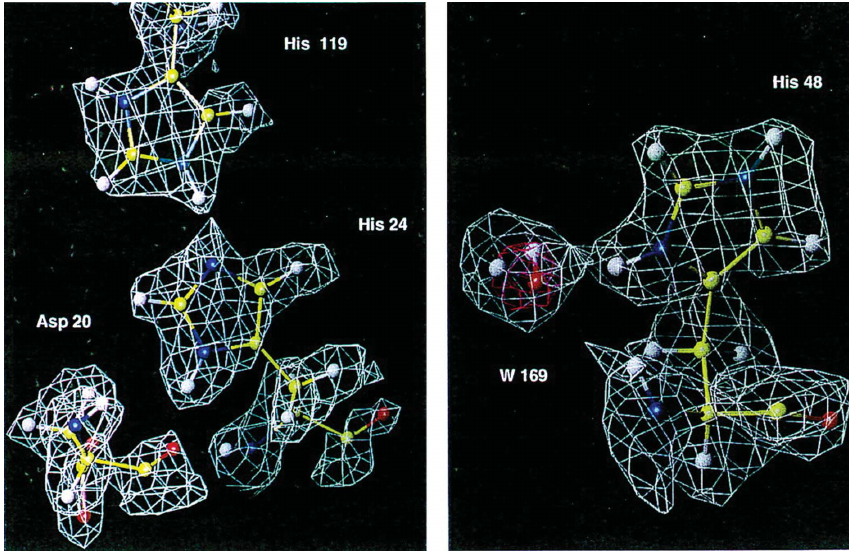
Figure 3 Nuclear density for perdeuterated myoglobin, showing positive density for nonexchangeable H (D) atoms. Reprinted with permission from Shu et al. (2000), Proc. Natl Acad. Sci. USA , 97 , 3872–3877. Copyright (2000) National Academy of